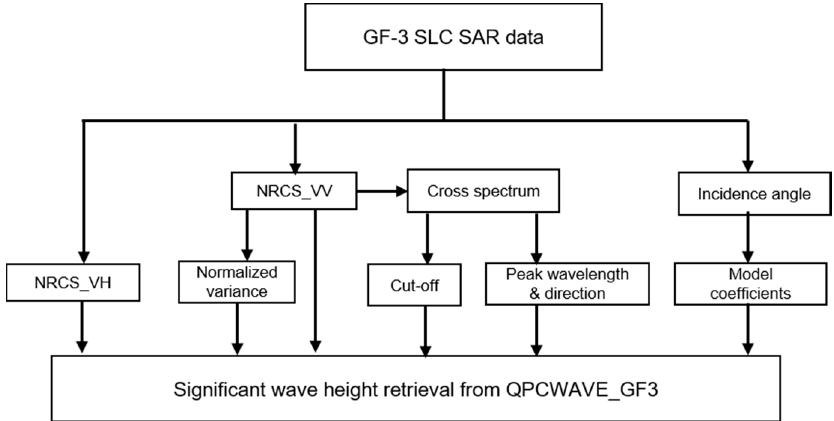
Figure 5. Flowchart of the empirical SWH retrieval scheme.